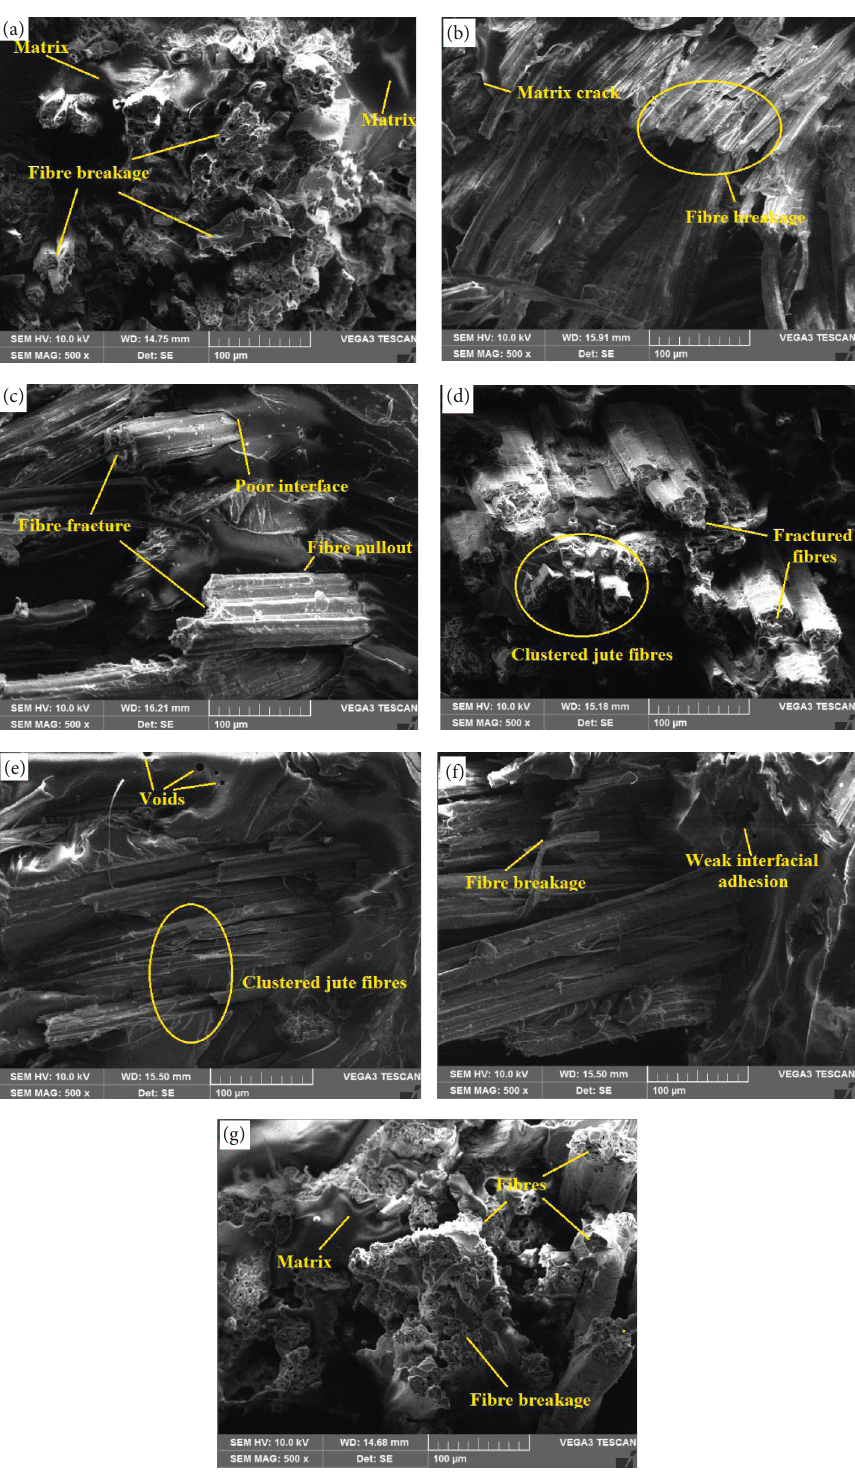
Figure 11: Fracture surfaces of tensile and flexural test specimens. (a) Sisal-untreated tensile. (b) Jute-untreated flexural. (c) Sisal 4% NaoH- treated tensile. (d) Jute 4% NaoH-treated tensile. (e, f) Jute 4% NaoH-treated flexural. (g) Sisal 4% NaoH-treated